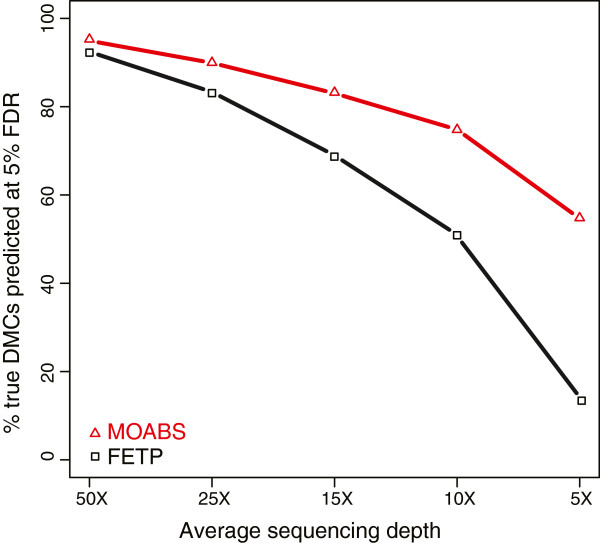
Comparison between MOABS and FETP in detecting DMCs. We simulated 1,000,000 CpGs in two samples with predefined true positive or true negative states. In both samples, 900,000 true negative CpGs were initially assigned the same methylation ratios. The density of the methylation ratios fits a bimodal distribution (Additional file 3: Figure S1) frequently observed in real BS-seq data. The remaining true positive 100,000 CpGs were randomly assigned at low ratios [0, 0.25] in one sample and high ratios [0.75,1] in the other sample, respectively. Each methylation ratio was then given a +/-0.05 fluctuation to simulate BS-seq errors. Sequencing depth is randomly sampled from 5-fold to 50-fold. The Y-axis shows the percentage of true DMCs predicted at 5% FDR.